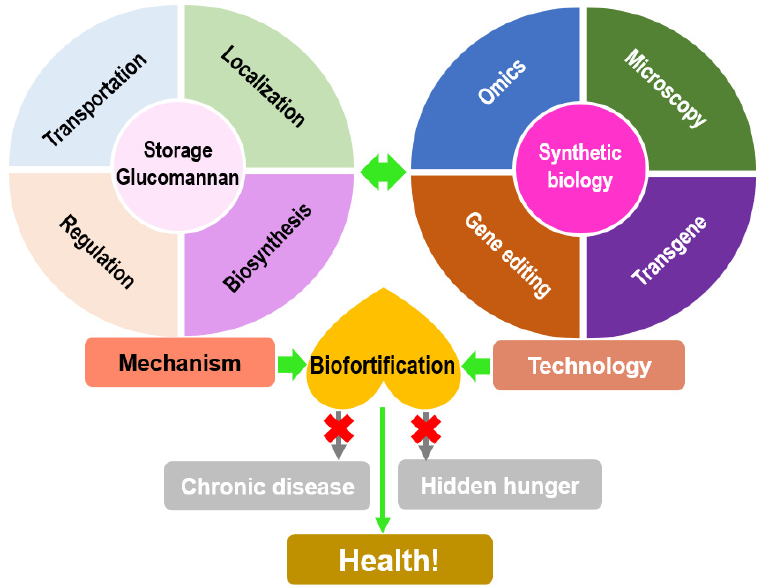
Figure 6. Biofortification strategy of glucomannan based on the in-depth dissection of molecular mechanisms and combined application of new-developed technologies.